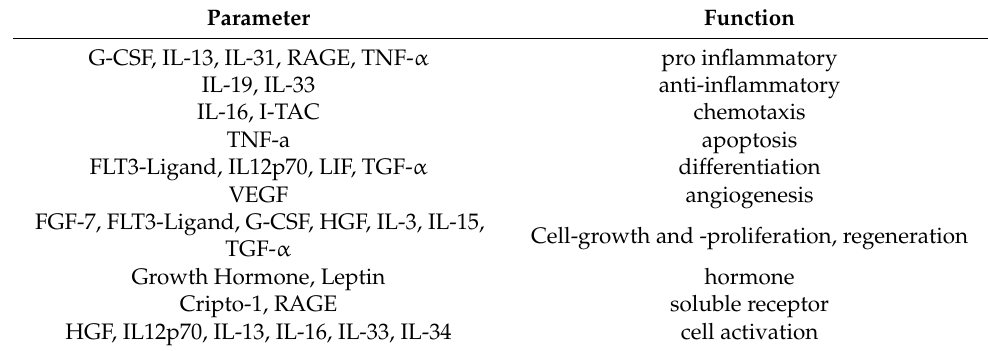
Table 5. Measured parameters with marginal or undetectable expression and assignment to cate-